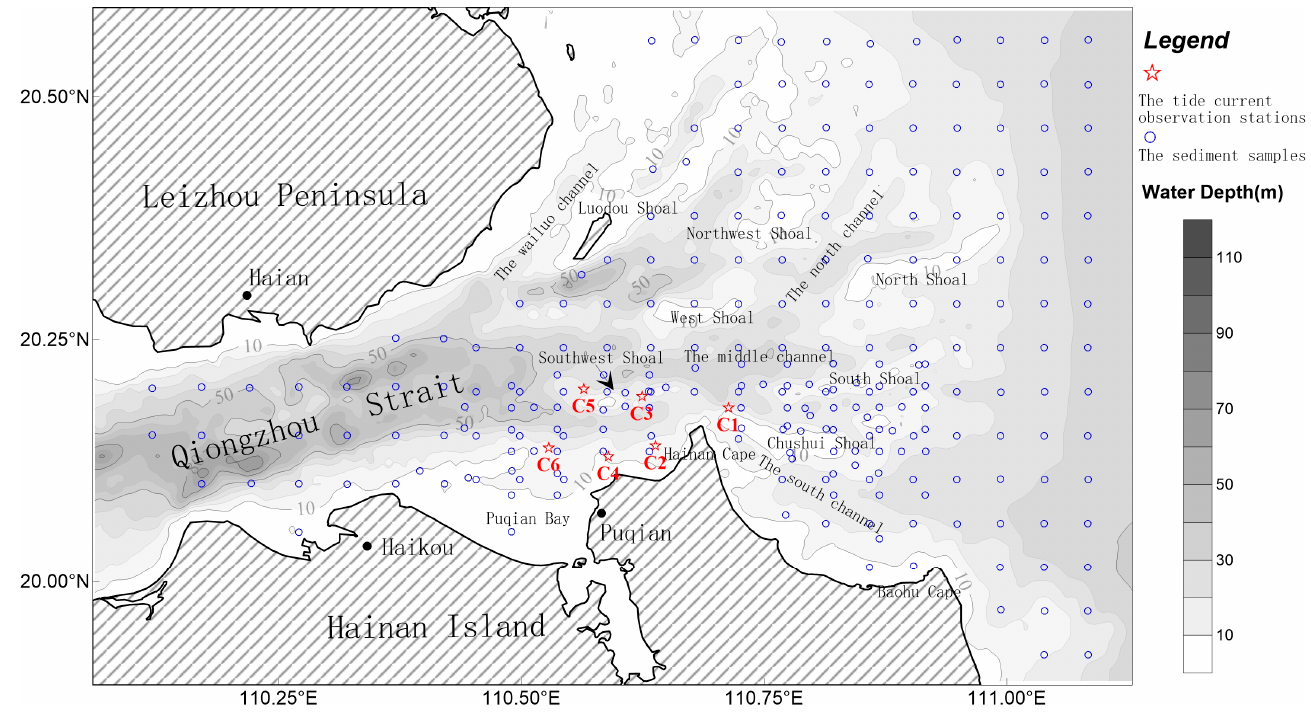
Figure 1. The topography and geomorphology of the east entrance of Qiongzhou Strait. Blue circles denote the seabed sediment sampling stations, Red asterisks denote the six field observation stations for tidal current.